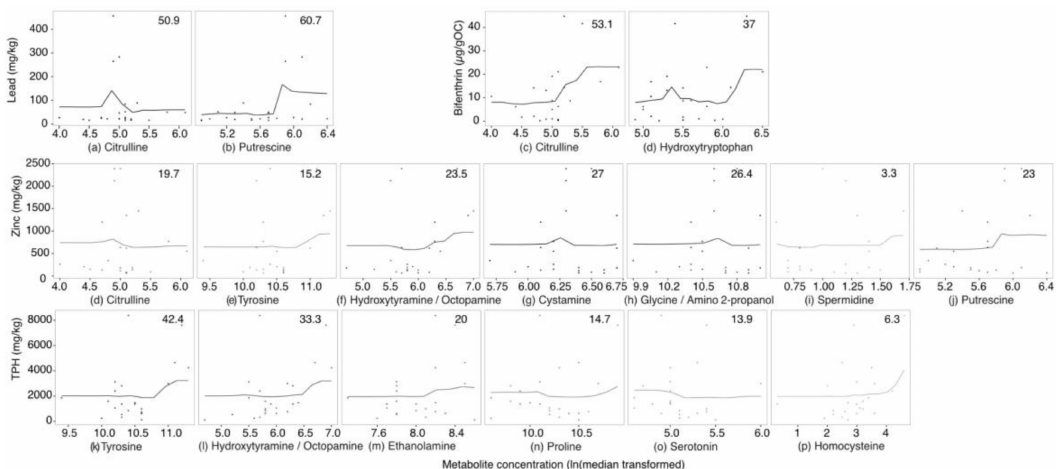
Figure 5. Results of random forest modelling, with partial dependence plots showing the association of Procladius villosimanus LC-MS metabolites with lead ( a , b ), bifenthrin ( c , d ), zinc ( d – j ) and total petroleum hydrocarbons (TPH) ( k – p ). Percent increase in mean squared error (%IncMSE) for each metabolite is indicated in the top corner of each panel and visualized with shading.